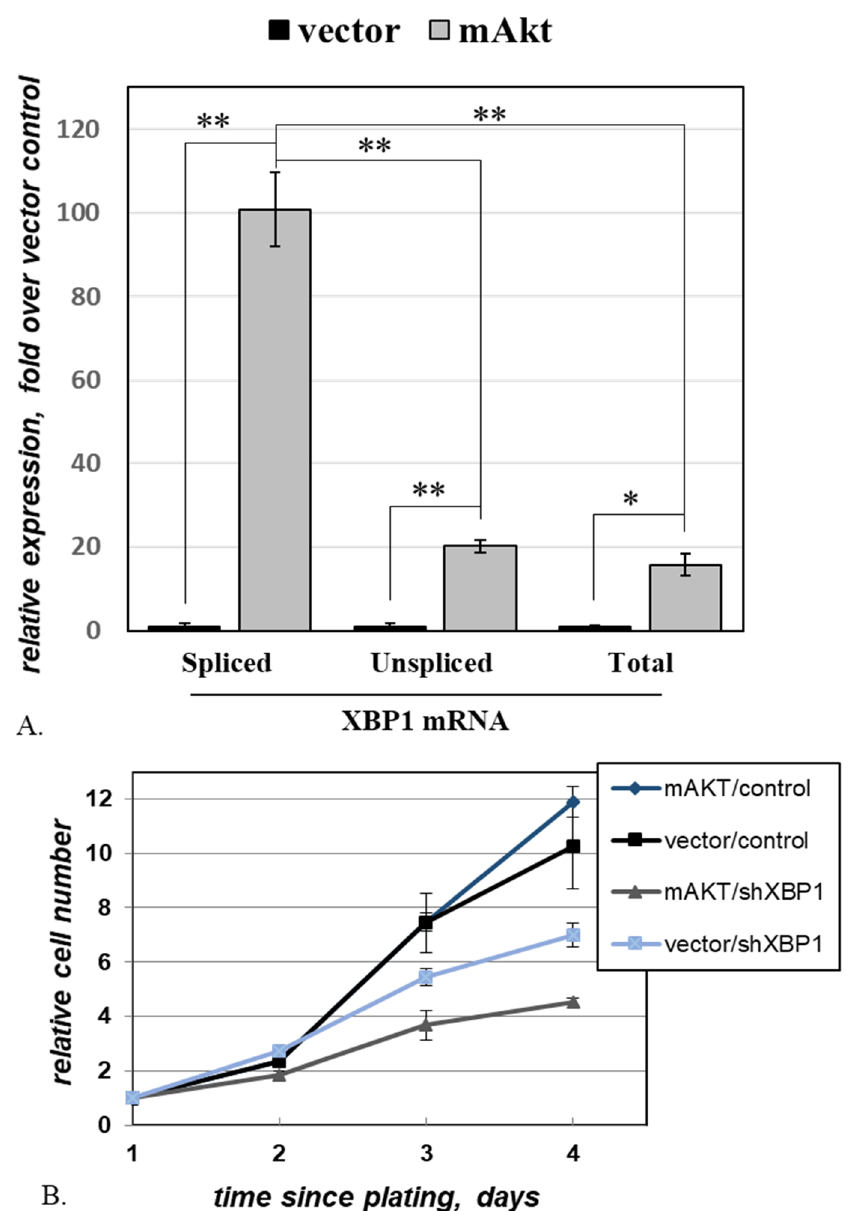
Figure 4. The heightened dependence on XBP1 in the presence of activated AKT. ( A ). MEF-AG cells transduced with mAKT or the respective empty vector were assayed for the expression of the indicated XBP1 transcripts using quantitative RT-PCR. After normalization to the GAPDH signal in the same samples, the values for XBP1 variants in each cell line were plotted relative to the average value in the empty vector control, and results analyzed using an ANOVA Tukey’s multiple comparisons test. Error bars represent standard deviations of triplicates. “*”- p = 5.0 × 10 − 3 . “**”- p < 1.0 × 10 − 4 . ( B ). MEF-AG cells harboring either mAKT or the respective empty vector were transduced with either the XBP1 shRNA or the respective control construct and plated at the same density for growth rate comparison. The remaining cells for each cell line were scored at the indicated time points after plating, and the values were plotted relative to those on day 1. Quadruplicate cultures of each cell variant were analyzed for each time point.